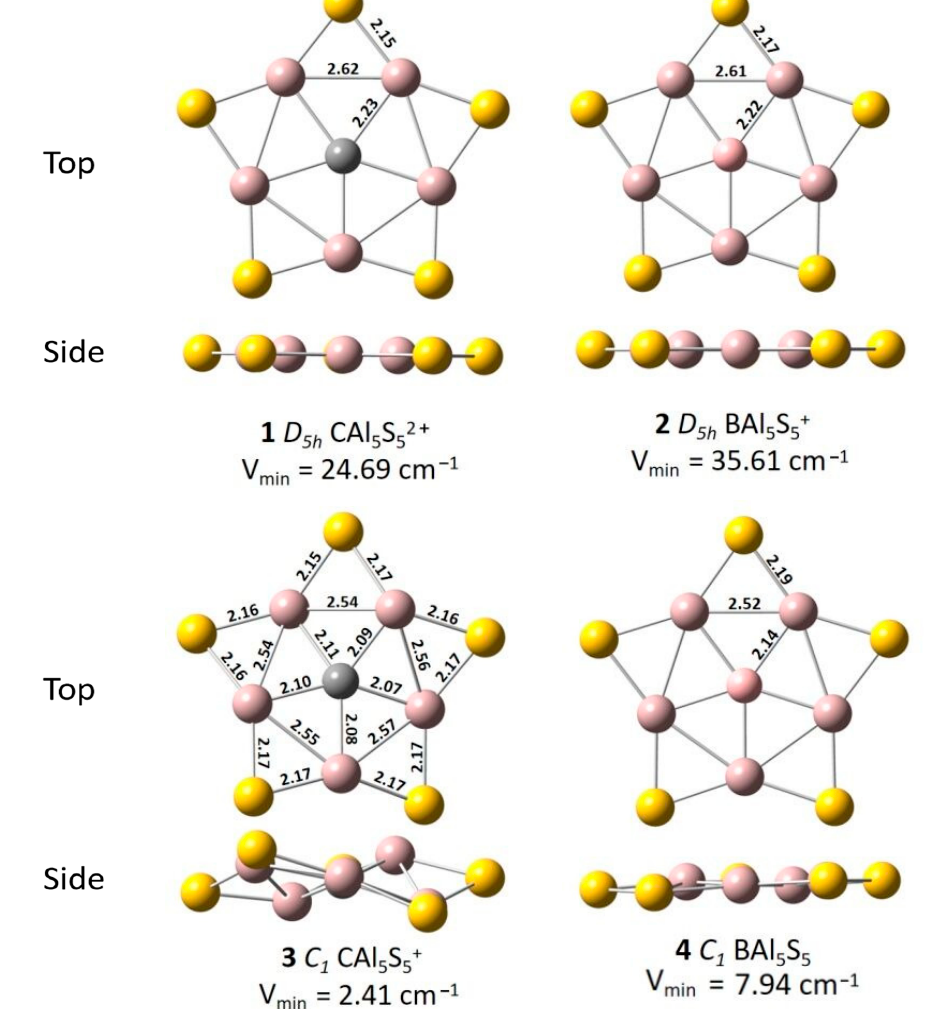
Figure 1. The Optimized Structures and Bond Lengths for XAl 5 S 5 (X = C, B; n = 0, +1, +2) clusters and their lowest frequencies at CCSD/6-31G(d) level.